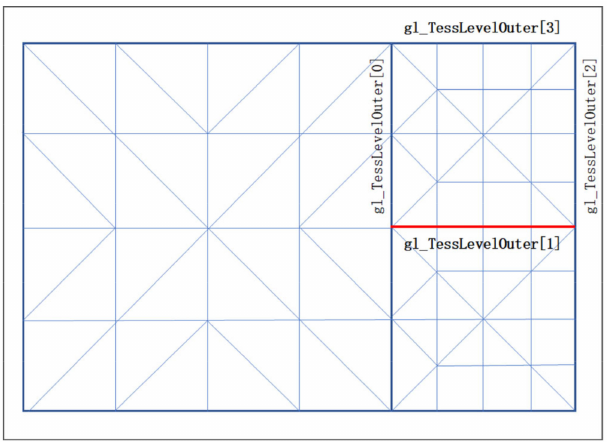
Figure 13. Diagram of edges of two